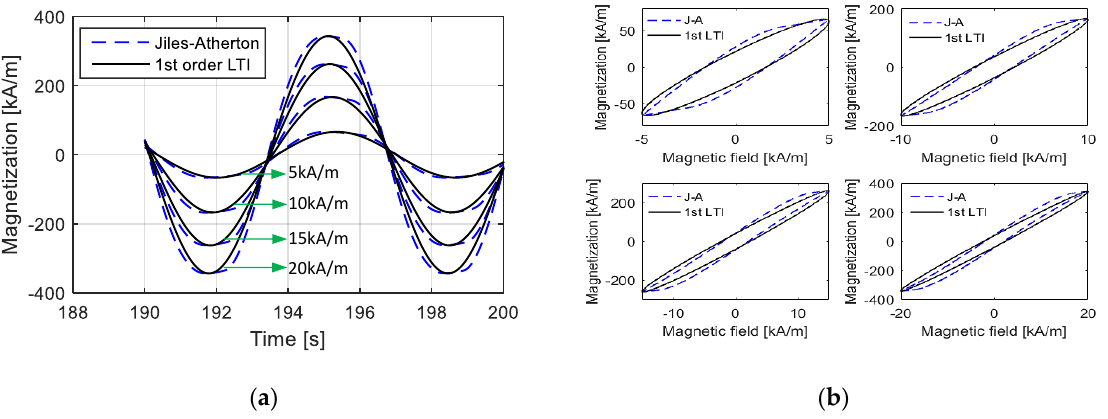
Figure 9. Comparisons of calculated magnetization curves from the Jiles – Atherton model and the 1st LTI system model under fixed parameters ( k = 2 kA/m, a = 12 kA/m, c = 0.2, α = − 0.001 and M S = 80 kA/m) during various magnetic field intensities with low amplitudes: ( a ) time − domain curves; ( b ) M − H curves.